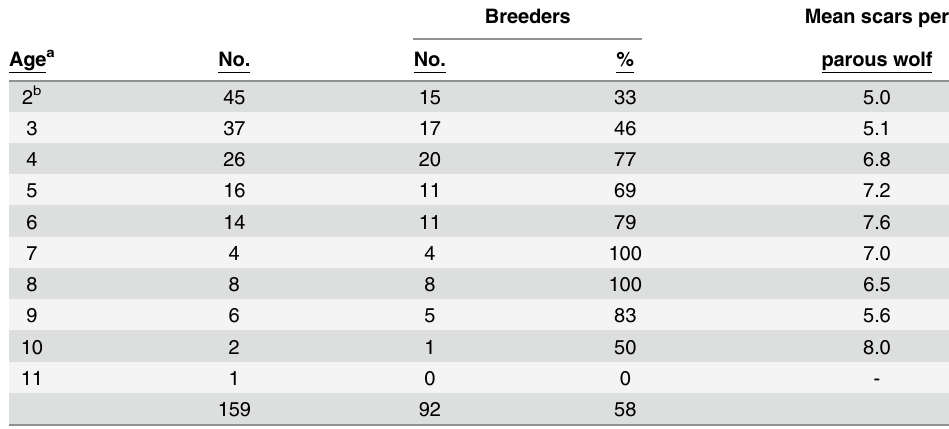
were sampled that many months later in the year. b Because there are few records of free-ranging 1-year-old wolves breeding, we assumed these 10 were miss-aged, so we eliminated this cohort and results from our analysis (but see Introduction).